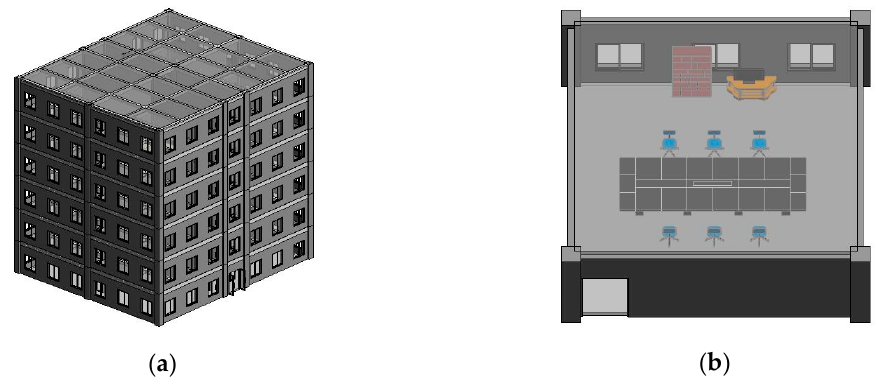
Figure 9. The selected building in case study, ( a ) information model; ( b ) indoor scene.